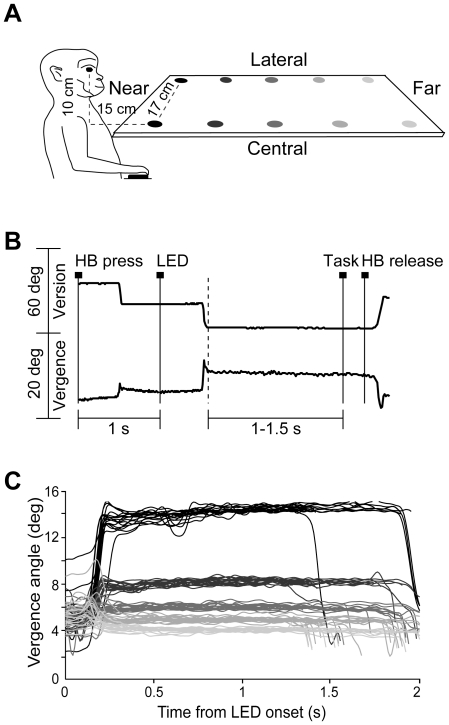
Experimental setup and task sequence.(A): Scheme of the set up used for the fixation in depth task. Eye movements were performed in darkness towards one of the ten LEDs of a horizontal panel. (B): Time course of the task. A typical example of the version (top) and vergence (bottom) traces during a single trial is shown. Long vertical continuous lines indicate the occurrence of events during the task. From left to right markers show: trial's start (HB press), target appearance (LED light on green), end of fixation (Task, green to red change of the LED) and trial end (HB release). Long vertical dashed line indicates the end of the saccade. (C): Calibrated vergence eye position signal (in degrees) during fixation of the LEDs of the central row (different tones of grey), in an example recording. Vergence angle is maintained for the whole required fixation (1 s–1.5 s) and is clearly distinguishable among the different targets.